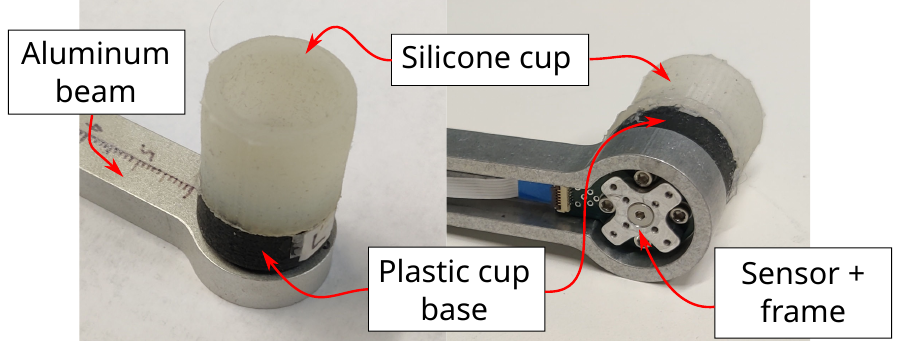
Figure 13. Realized implementation of overall finger assembly viewed from top and